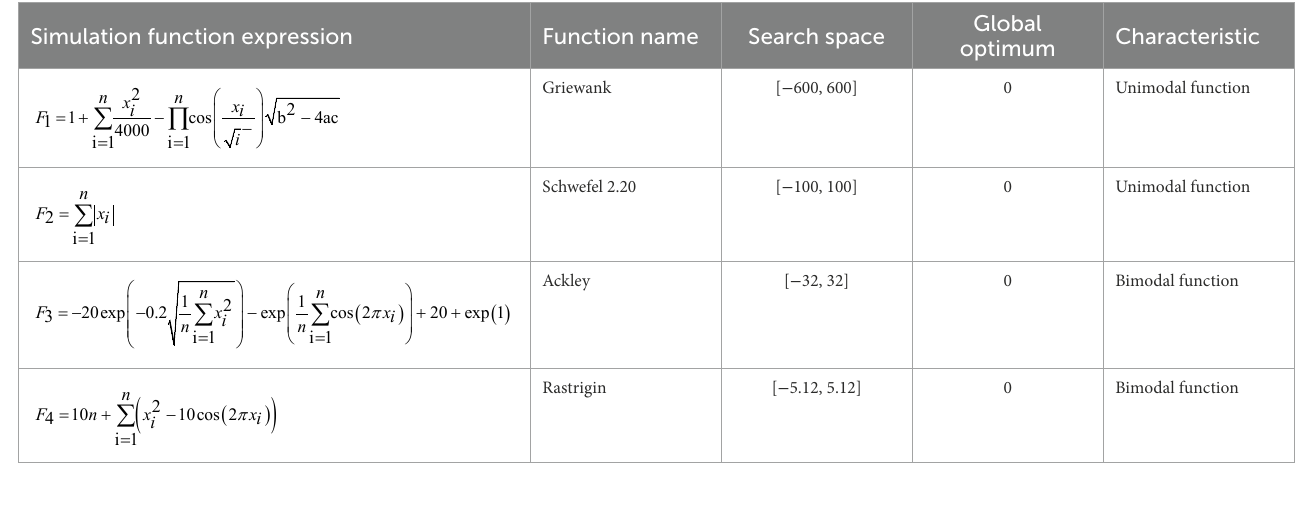
TABLE 3 Four simulation test functions.